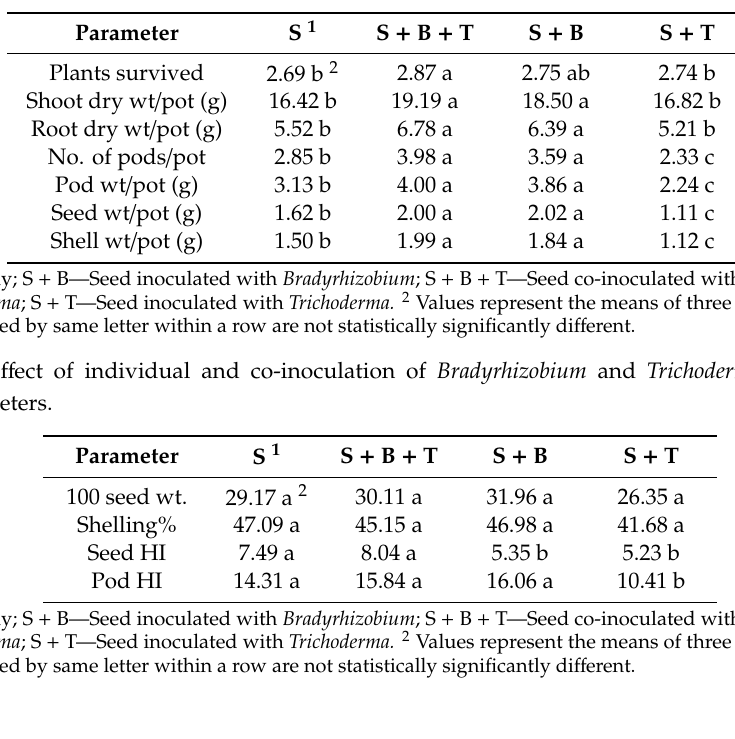
Figure 2. Comparison of biweekly Soil Plant Analysis Development (SPAD) chlorophyll readings of uninoculated control, co-inoculated with Bradyrhizobium and Trichoderma , inoculated with Bradyrhizobium , and inoculated with Trichoderma . S—Seed only; S + B—Seed inoculated with Bradyrhizobium ; S + B + T—Seed co-inoculated with Bradyrhizobium and Trichoderma ; S + T—Seed inoculated with Trichoderma Table 4. E ff ect of individual and co-inoculation of peanut with Bradyrhizobium and Trichoderma on plant survival, growth, development, and yield.